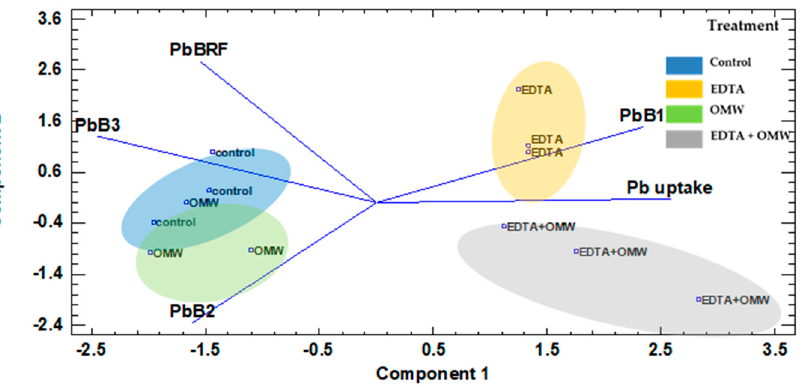
soil fractions among different treatments. B1: exchangeable/weak acid soluble; B2: reducible; B3: oxidizable; BRF: residual fraction; OMW: olive mill wastewater.